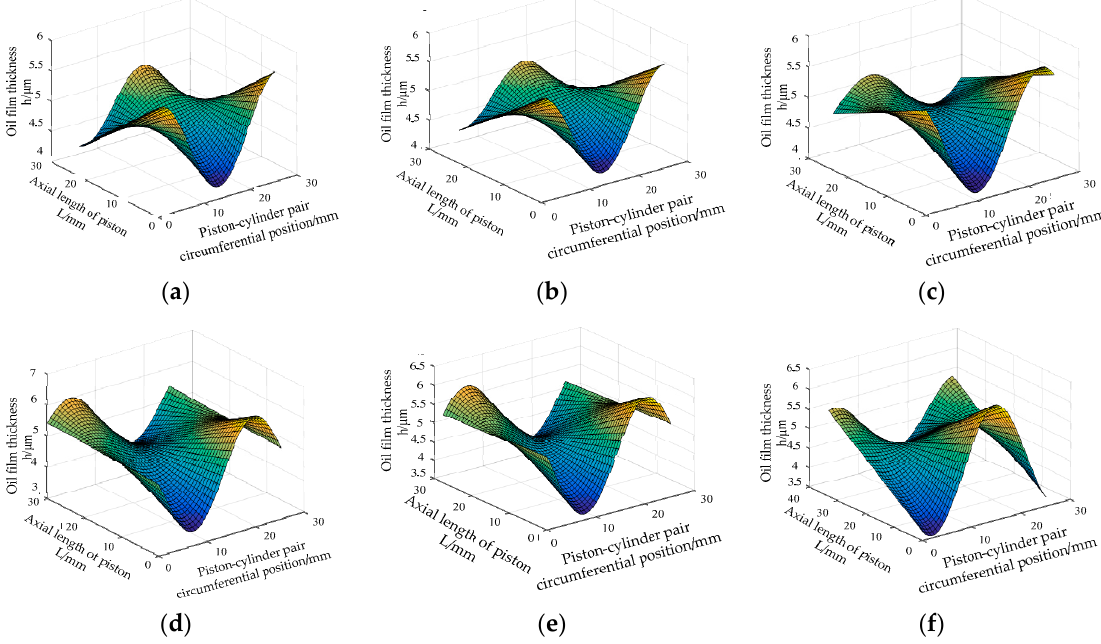
Figure 6. The figure shows the result of oil film thickness at different angle of inclined plate rotation: ( a ) Oil film thickness distribution with swashplate rotation of 1°; ( b ) oil film thickness distribution ( a ) Oil film thickness distribution with swashplate rotation of 1 ◦ ; ( b ) oil film thickness distribution with swashplate rotation of 10°; ( c ) oil film thickness distribution with swashplate rotation of 45°; ( d ) with swashplate rotation of 10 ◦ ; ( c ) oil film thickness distribution with swashplate rotation of 45 ◦ ; oil film thickness distribution with swashplate rotation of 90°; ( e ) oil film thickness distribution with ( d ) oil film thickness distribution with swashplate rotation of 90 ◦ ; ( e ) oil film thickness distribution swashplate rotation of 110°; ( f ) oil film thickness distribution with swashplate rotation of 210°. with swashplate rotation of 110 ◦ ; ( f ) oil film thickness distribution with swashplate rotation of 210 ◦